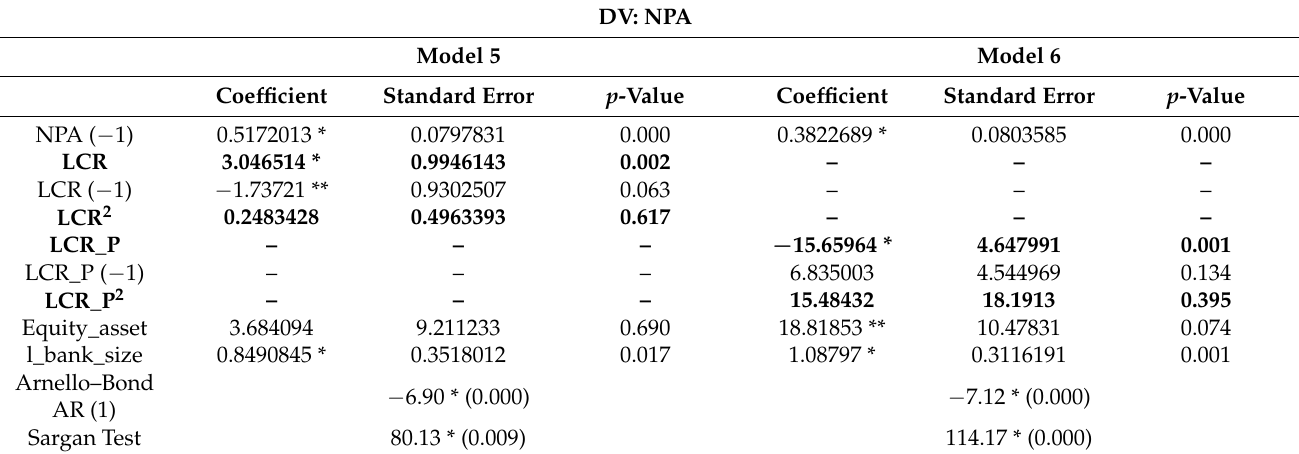
Table 6. Dynamic Panel Data Model (Models 5 and 6).